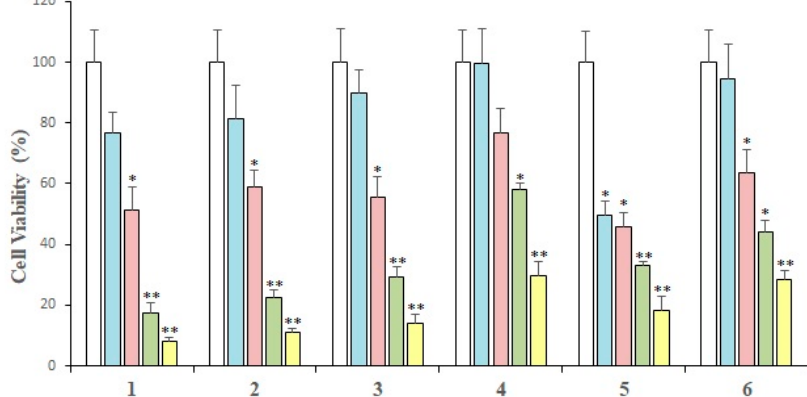
Figure 2. The cytotoxic effects of compounds 1 – 6 (isolated from L. shawii ) on MDA-MB-231 breast cancer cells. All results are expressed as mean ± SEM. * p < 0.05 and ** p < 0.01 , compared to respective untreated controls.